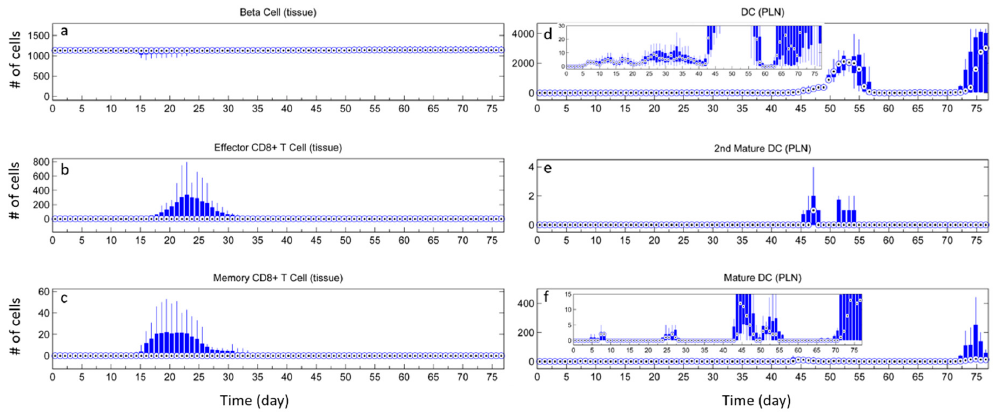
Figure 6. Simulation results for case with Tregs (case II). There are initial Tregs and conversion ability of CD4 + T cells. The number of ( a ) β cells, ( b ) effector CD8 + T cells, ( c ) memory CD8 + T cells- in pancreatic tissue are shown on the left column. The number of ( d ) total DCs, ( e ) 2nd mature DCs, ( f ) mature DCs in PLN are shown on the right column. Inserts (number of cells vs. time) show small change of cell number in the bottom figures. t = 0 day corresponds to 3-week age of mouse.